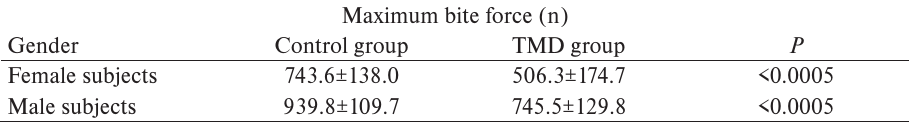
Table 3. Comparative analysis of MBF between female and male subjects of the observed group.